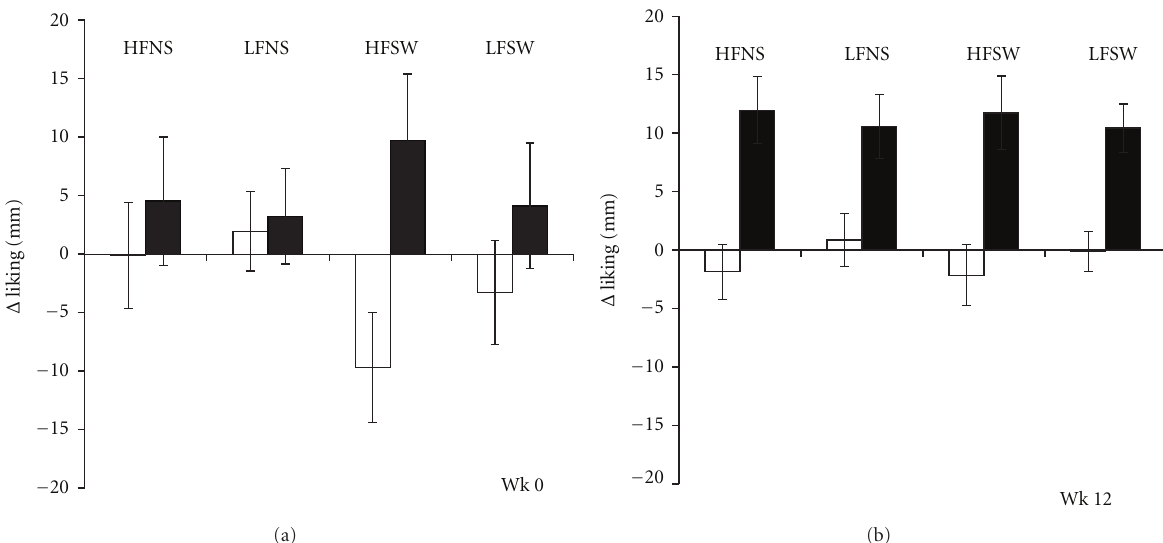
Figure 2: Acute changes in liking for food categories measured before and after a single bout of exercise in Responders ( (cid:2) ) and Nonresponders ( (cid:3) ). HF: high fat, LF: low fat, NS: non-sweet, SW: sweet.